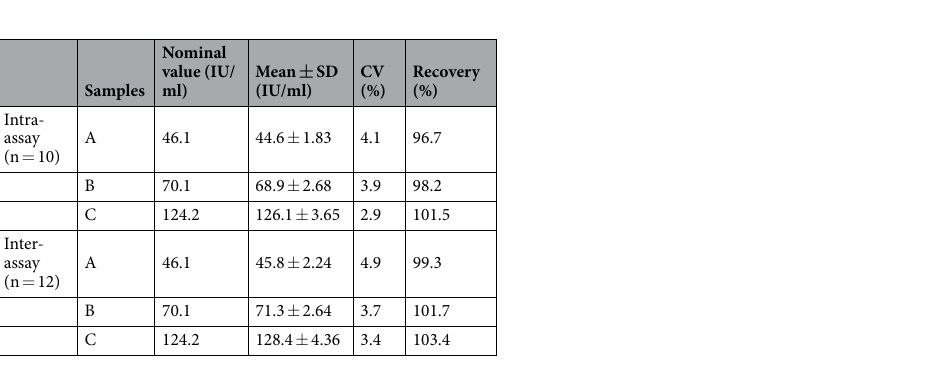
Table 2. Repeatability and recovery of the present TRFIA. CV: coefficient of variation. SD: standard deviation.